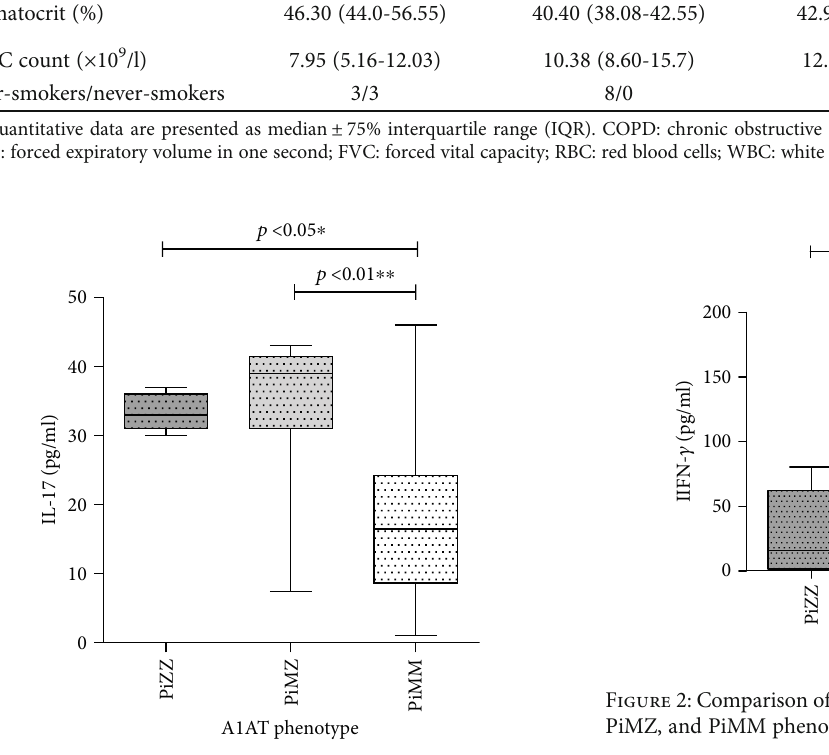
Figure 1: Comparison of IL-17 levels in COPD patients with PiZZ, PiMZ, and PiMM phenotypes of A1AT.